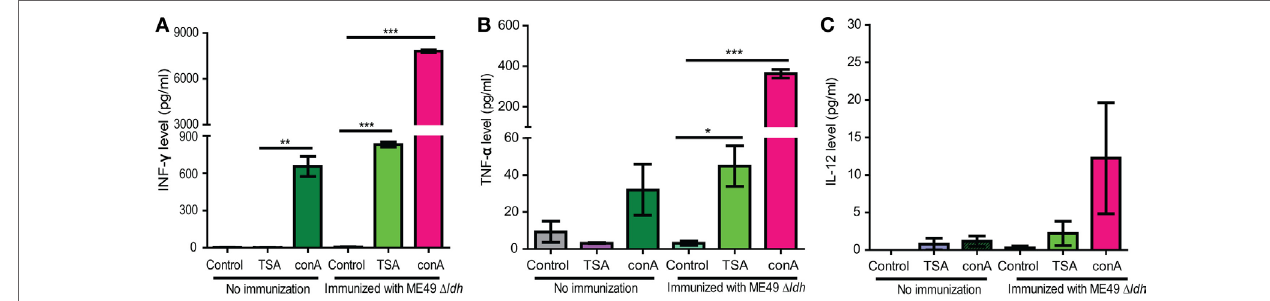
FigUre 8 | Cytokine production by splenocytes of ME49 Δ ldh -vaccinated mice after Toxoplasma antigen stimulation. ICR mice were vaccinated with 10 3 tachyzoites of ME49 Δ ldh and splenocytes were harvested 160 days post-vaccination. The in vitro cultured splenocytes were then treated with fetal bovine serum (control), total soluble Toxoplasma antigen (TSA) or Concanavalin A (conA, positive control) for 72 h. Subsequently the levels of IFN- γ (a) , TNF- α (B) and IL-12 (c) in the culture supernatants were measured by ELISA. Splenocytes isolated from non-immunized naïve mice were included as controls. Three mice from each group were analyzed and each treatment condition was repeated three times, * p < 0.05, ** p < 0.01, *** p < 0.0001, Student’s t